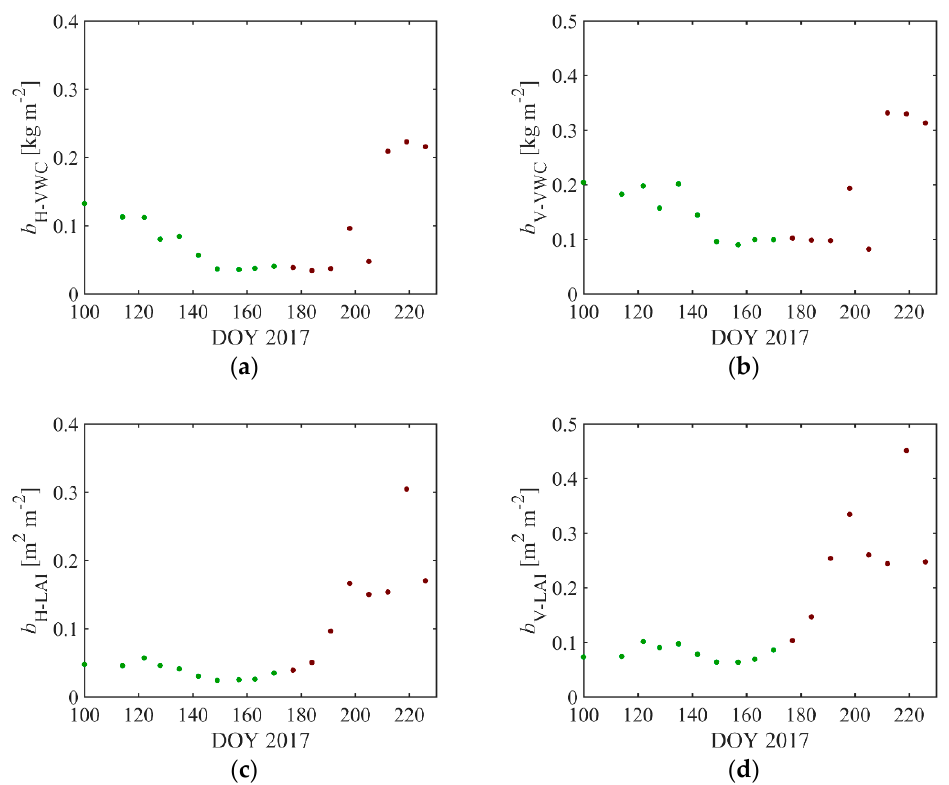
Figure 10. Computed b parameters from the 40° angle τ retrievals using Equations (6) ( a , b ) and (7) ( c , d ) at H ( left ) and V ( right ) polarization. Green circles indicate the vegetative stages and brown circles indicate the senescence stages.